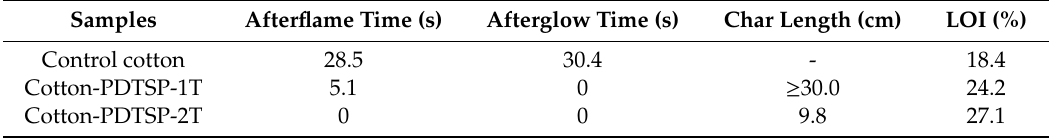
Figure 3. Digital photographs of cotton fabrics after VFT under different coating layers. Table 2. Results of VFT and LOI test of cotton fabrics with different layers.